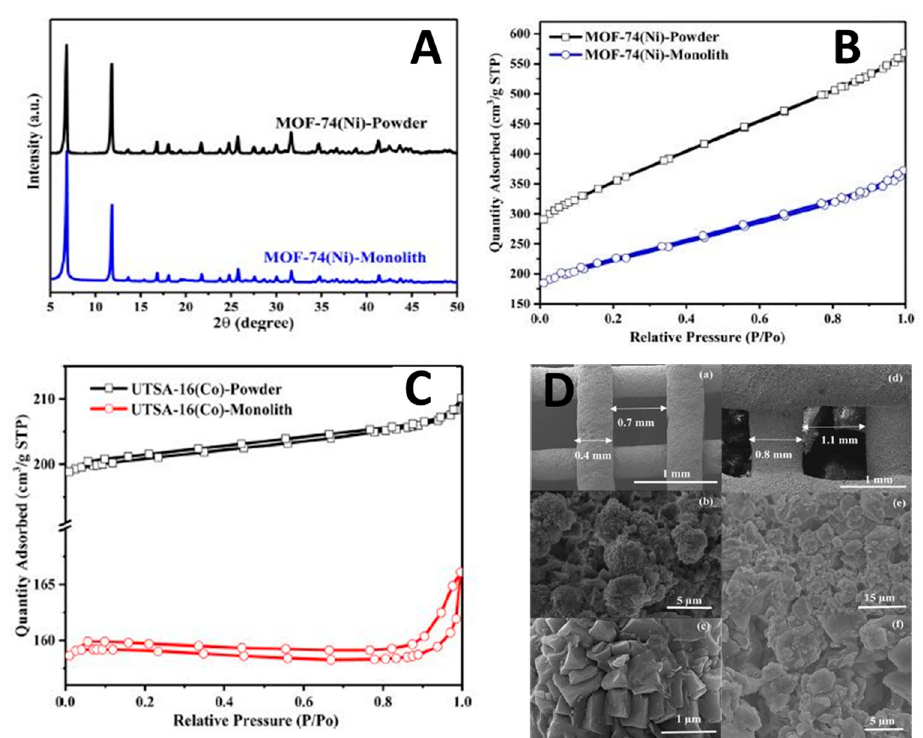
Figure 16. XRD patterns for 3D-printed ( A ) MOF-74(Ni) and UTSA-16(Co) monoliths with their powder counterparts. Nitrogen physisorption isotherms and pore size distribution curves for 3D-printed MOF monoliths: ( B ) MOF-74(Ni) and ( C ) UTSA-16(Co) and their corresponding powders. ( D ) SEM images of 3D-printed (a − c) MOF-74(Ni) and (d–f) UTSA-16(Co) monoliths. Reproduced with